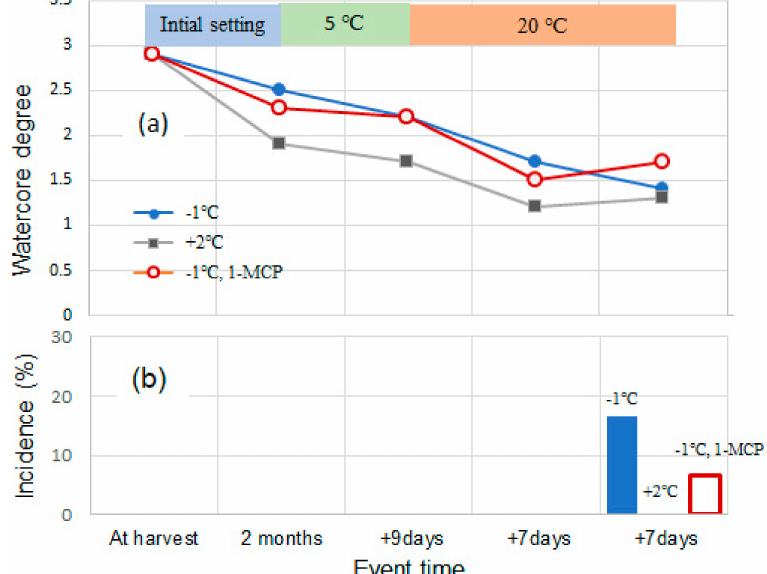
Figure 5. Time course of watercore degree (0–4) and watercore breakdown incidence (area %) in ‘Fuji’ apple. n = 30. ( a ) Watercore degree, ( b ) watercore breakdown incidence. Watercore